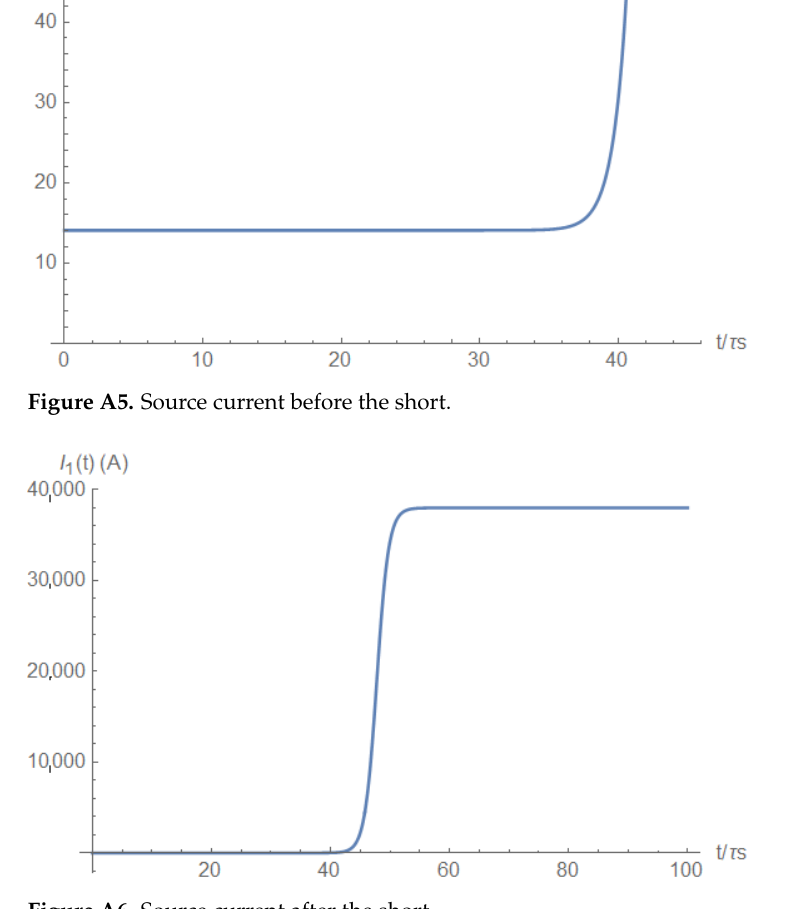
Figure A6. Source current after the